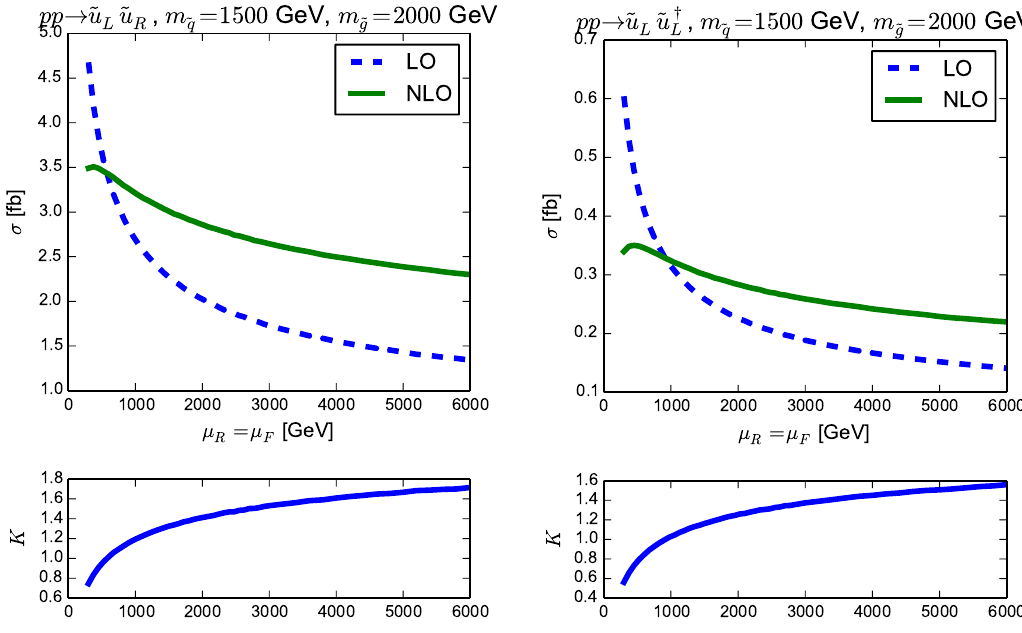
Figure 14. Scale dependency of the cross section for ~ u L ~ u R (left) and ~ u L ~ u y the MRSSM at LO and